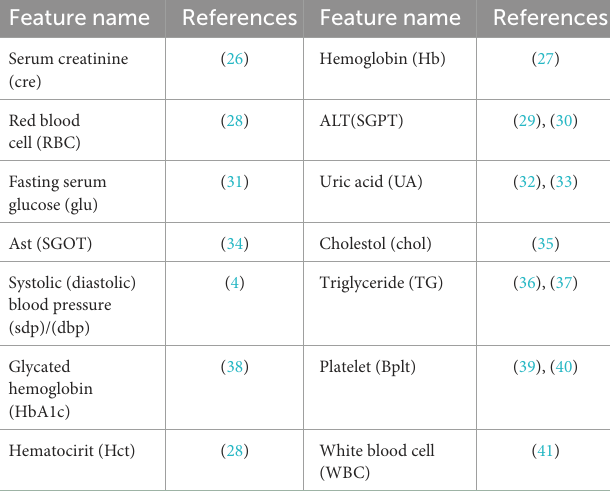
TABLE 2 Metabolic factors causing BMI or obesity based on previous